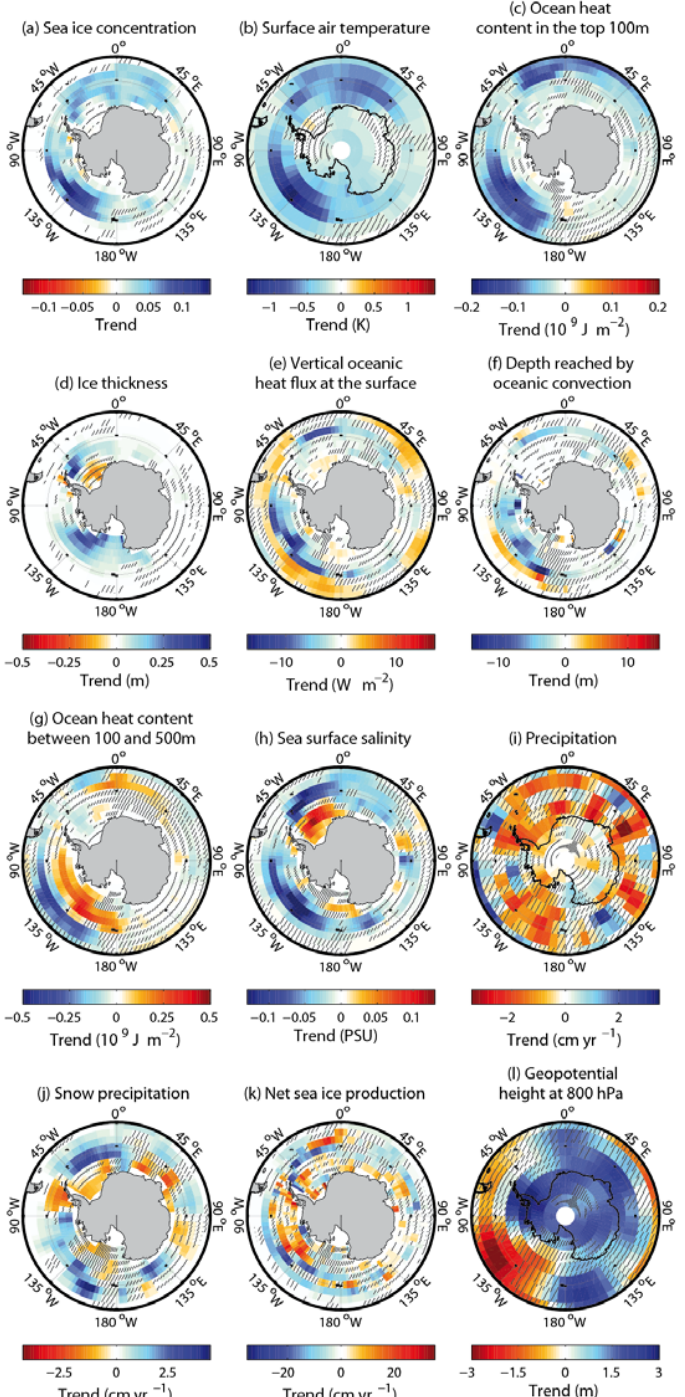
Fig. 2. Trends in annual means averaged over the 11 periods showing a large increase in Antarctic sea ice extent scaled to represent 30 year changes of (a) ice concentration, (b) surface air temperature (K), (c) ocean heat content in the top 100m (Jm − 2 ) , (d) ice thickness (m), (e) vertical oceanic heat flux at the ocean surface (positive upward, Wm − 2 ) , (f) depth reached by oceanic convection (m), (g) ocean heat content in the layer between 100 and 500m (Jm − 2 ) , (h) sea surface salinity, (i) total precipitation (cmyear − 1 ) , (j) snow precipitation (cmyear − 1 water equivalent), (k) net sea ice production (production minus melting) (cmyear − 1 water equivalent), and (l) geopotential height at 800hpa (m). The hatched areas represent the regions for which the average trend over the 11 periods is not significantly different at the 95% level from the mean trend in periods of identical length but not showing a large increase in ice extent.